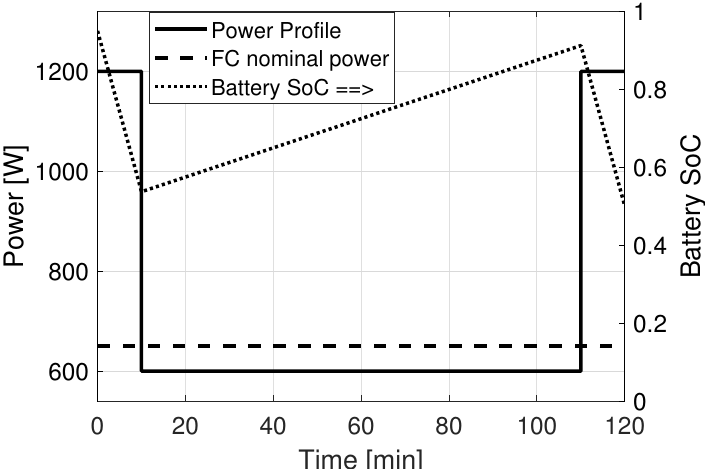
Figure 12. Electric power profile and estimated battery SoC of the typical mission consisting of three phases, 10 min take off, 100 min cruising and 10 min landing. The simulation considers a fuel cell stack with 650 W nominal power, 80 g hydrogen, and a 100 Wh battery with an initial SoC at